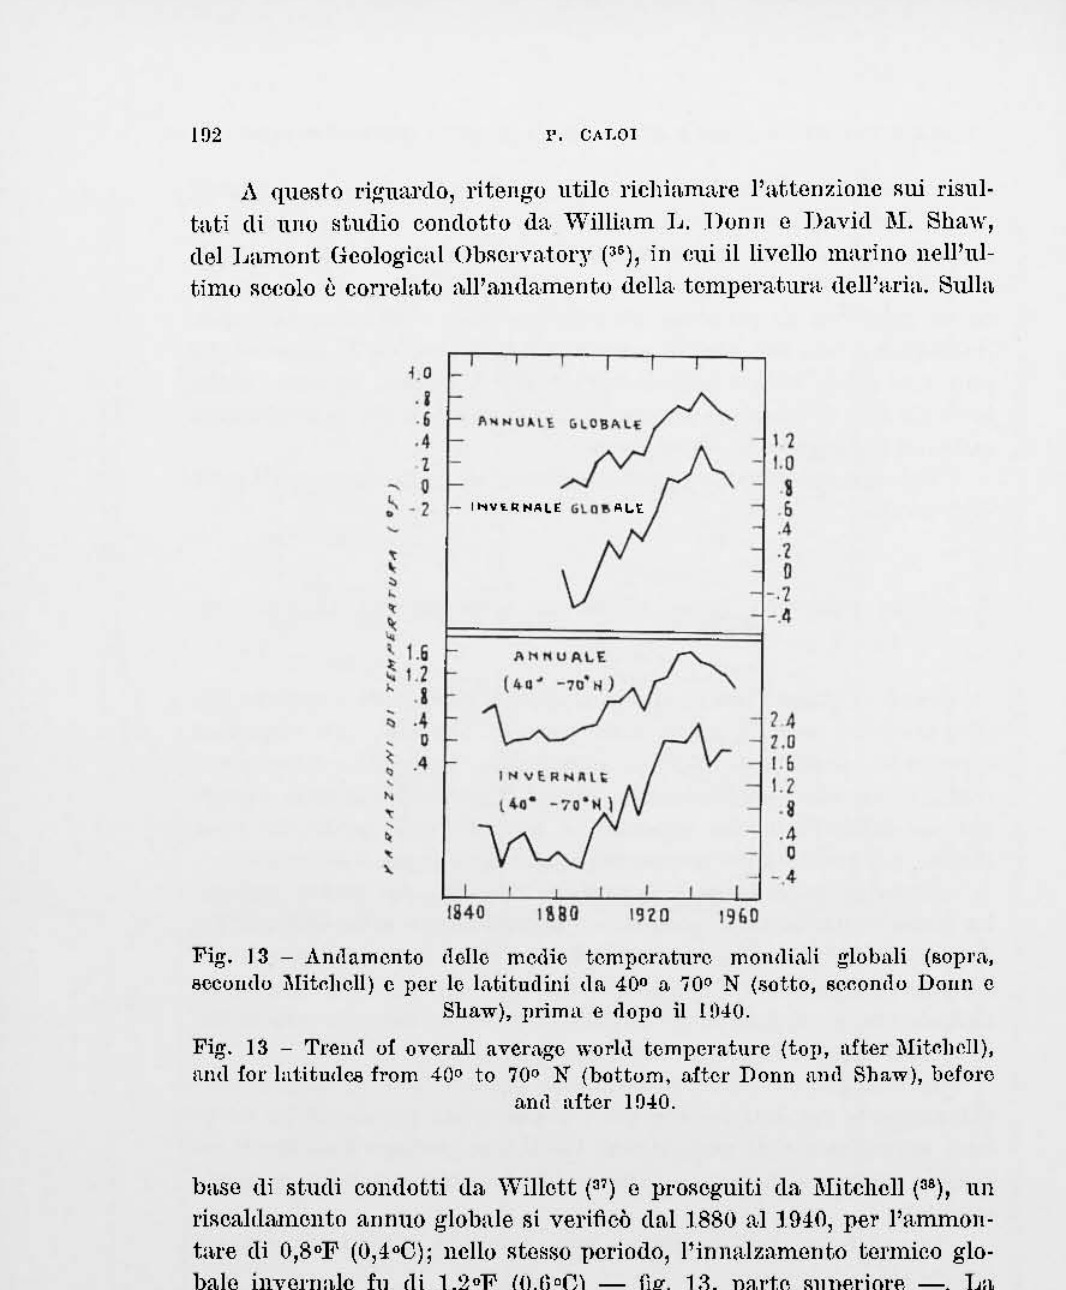
Fig. 13 - Andamento delle medie temperature mOIHIiali globali (sopra, 8ocondo :Mitclwll) e per le lat.itudini da 4()o a 700 N (sotto, sellondo Donn e Sltaw), prima e flopo il 1!140. Fig. 13 - Trelld of ovemll average worltl temperature (top, after MitdIPll), amI for lat.itm1cs from 400 to 700 N (bottom, after Donn aJ](] Shaw), bcfol'e and after